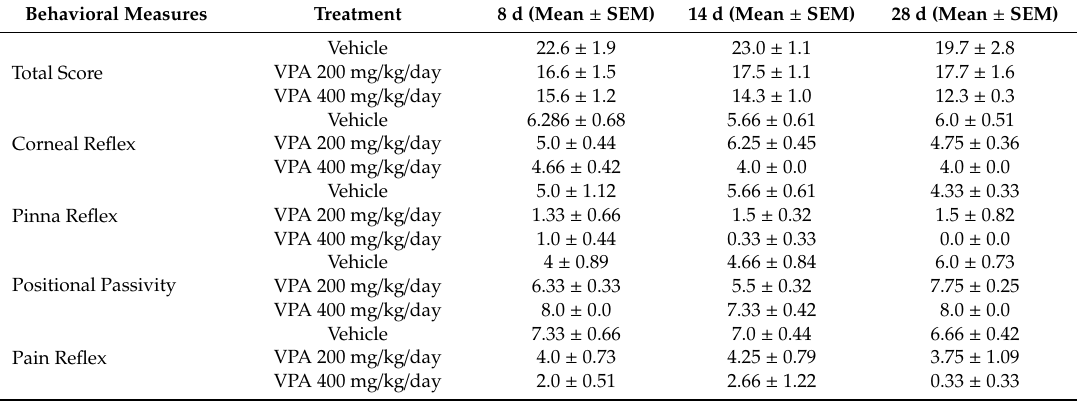
Table 1. The e ff ect of valproic acid (VPA) on Irwin’s behavioral measures. Data presented at mean ± SEM ( n = 6–7 / group).